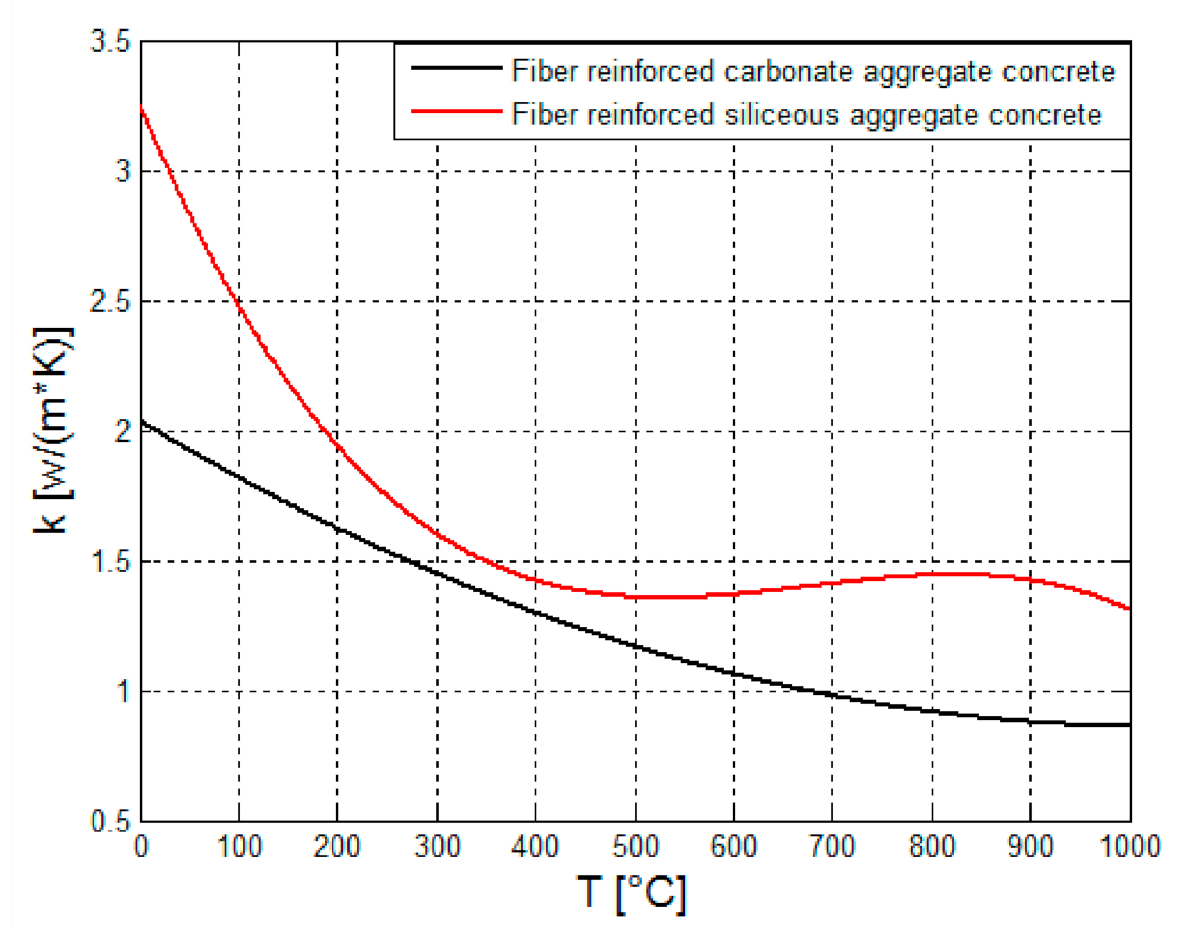
Figure 4. Thermal conductivity of various concrete types as a function of temperature